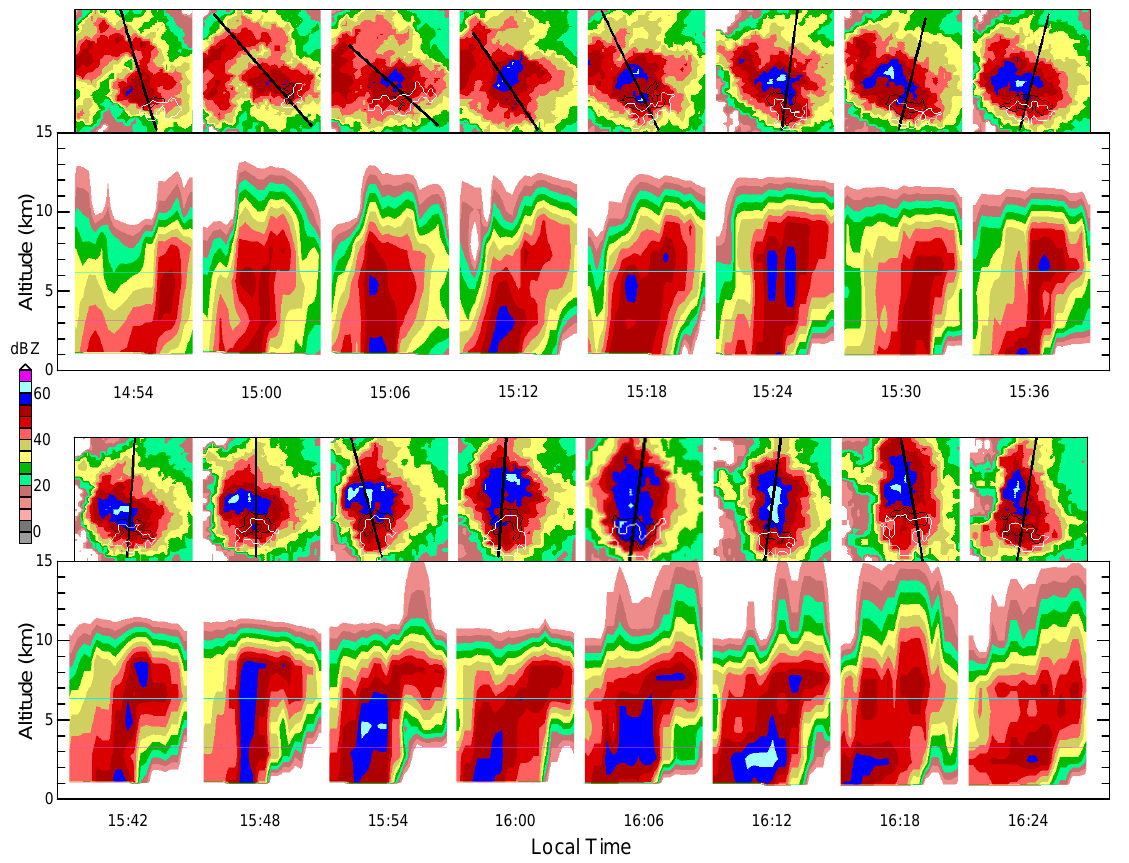
Figure 14. Composite reflectivity images (above) and vertical cross-section images generated automatically by the algorithm (below) of cells at each time step of Case 1 (10 June 2014). Images are superpixel-interpolated. In each composite reflectivity image, the black line is the cross-section line, and white and black contours are the locations of overhang echoes and tilted wall echoes, respectively. In each cross-section image, horizontal pink and blue lines refer to the melting layer and layer, respectively.